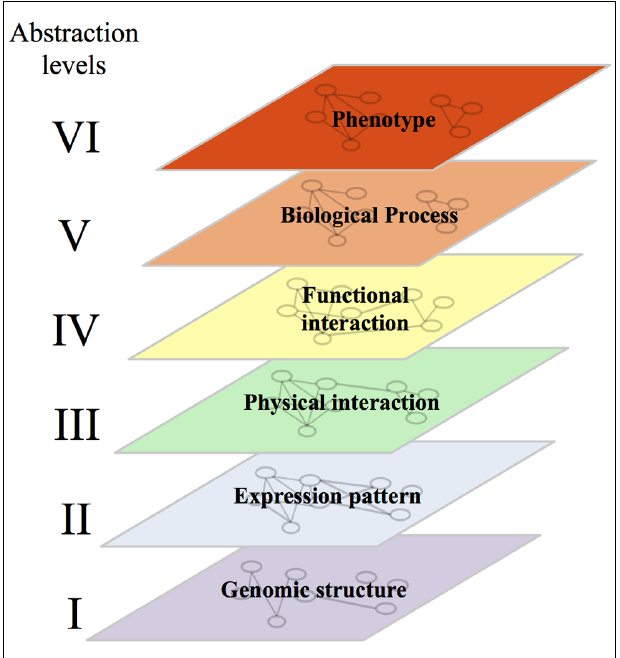
FIGURE 2 | Representation of the six levels of abstraction in biological systems. Note that, while each gene/protein can be followed from one abstraction level to another, the relationships linking it with its neighbors are different at each level.The conservation of links between two levels of abstraction in a given system and between orthologous genes/proteins in different systems are discussed in the main text of this